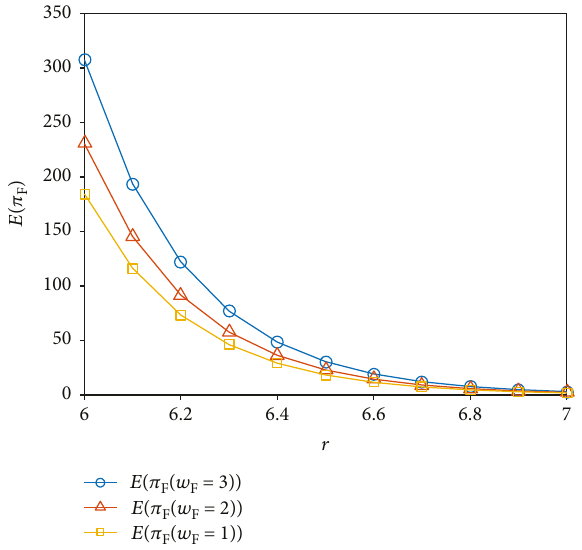
Figure 4: Contrast of performance of the company, farmer, and supply chain